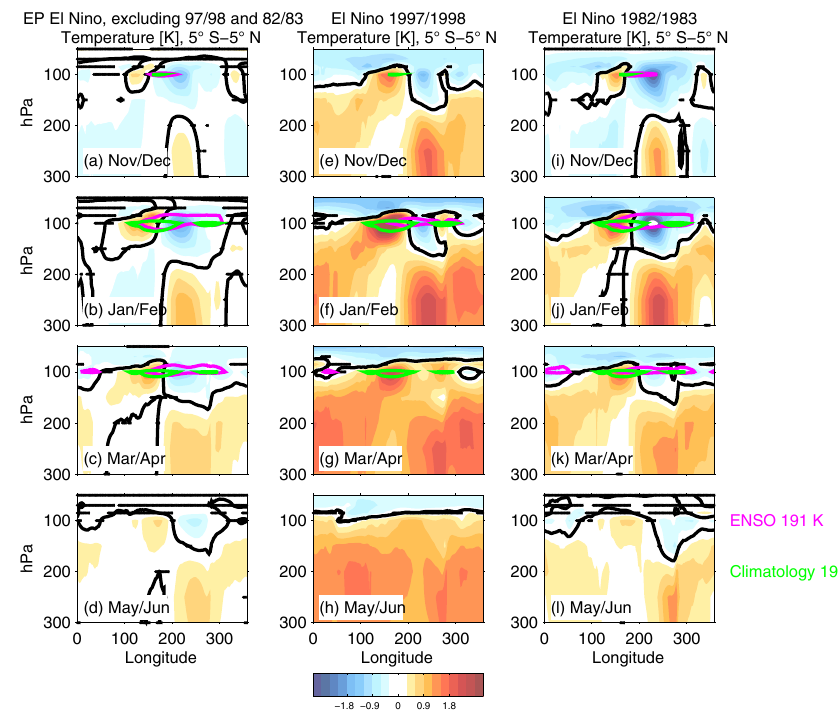
Figure 8. Tropical (5 ◦ S–5 ◦ N) temperature anomalies (Kelvin) (a–d) for all EP EN events excluding 1997/1998 and 1982/1983, (e– h) 1997/1998, and (i–l) 1982/1983, in the AGCM simulations. Anomalies that are not significant at the 95% level are marked by black symbols. The green and magenta contours denote specific cold isotherms in the climatology and for this specific composite in order to high- light the location of the cold point. The effect of the QBO at 50hPa and the linear trend have been linearly regressed out of all anomalies before ENSO composites are formed (see Sect. 3). The contour interval is